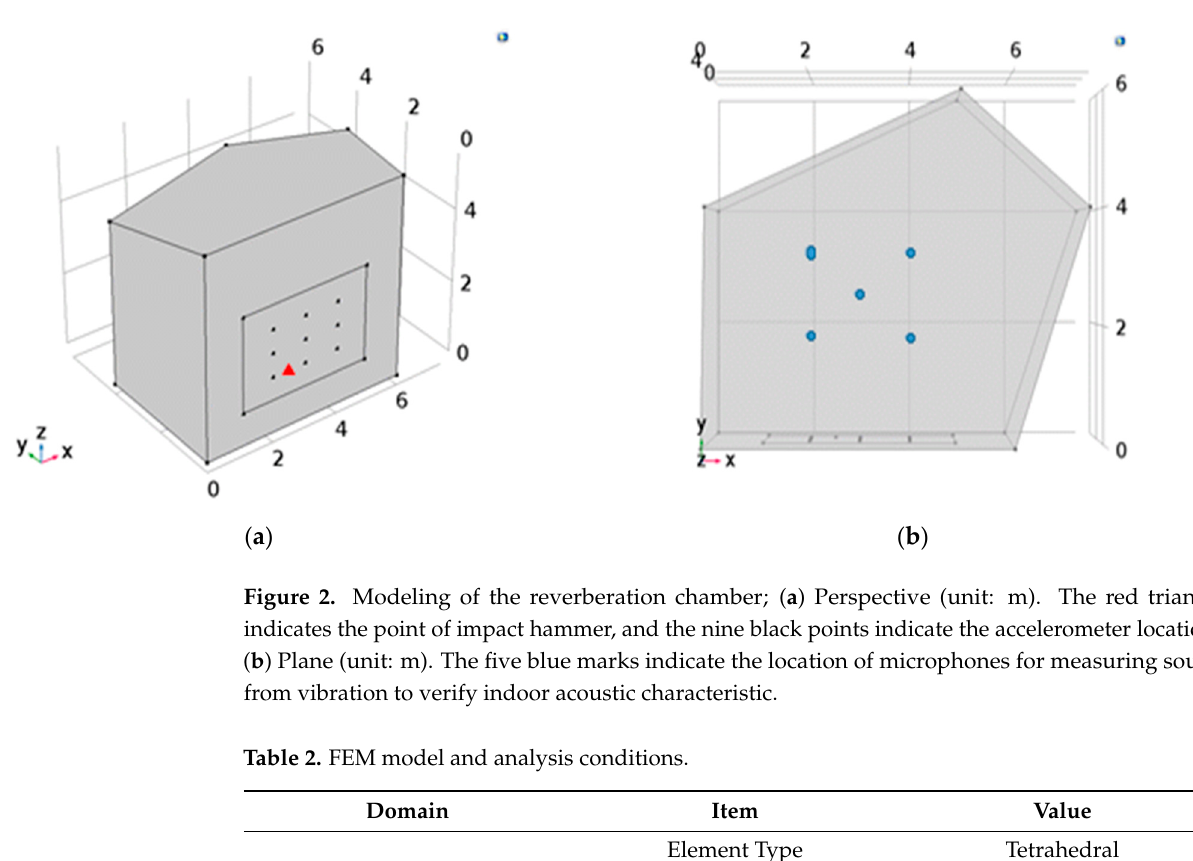
7 of 17 Figure 1. Covariance ratio: The graph was given by normalization from theory. If the difference between vibration mode and acoustic mode was larger, the frequency ratio became larger numeri- cally. 3. Modeling To simulate the structure–acoustic coupling system, a system consisting of a rever- beration chamber with a shell on one side was configured. COMSOL was used to perform the time-domain coupling analysis. The modeled structure is shown in Figure 2. Figure 2a shows the shell (3.8 × 2.6 m) on one side of the reverberation chamber, locations of nine accelerometers installed at the intersections of the four quarters horizontally and vertically on the shell plane, and vibration point (red triangle) in the bottom left part of the shell. Figure 2b shows the plane of the reverberation chamber, along with the locations of five microphones (at a height of 1.2 m). Table 1 presents the properties of the material used for modeling. The shell thickness was varied to examine the vibration behaviors associated with the 10 Hz band, and the primary natural frequency was set as approximately 17 Hz. The Rayleigh damping parameters α , β were used to represent the shell’s damping, and